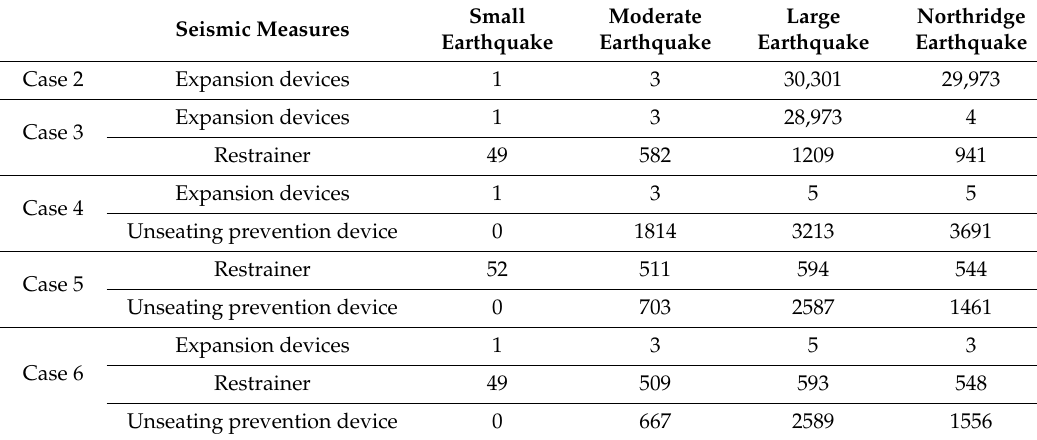
Table 3. Maximum internal force of seismic measures under di ff erent